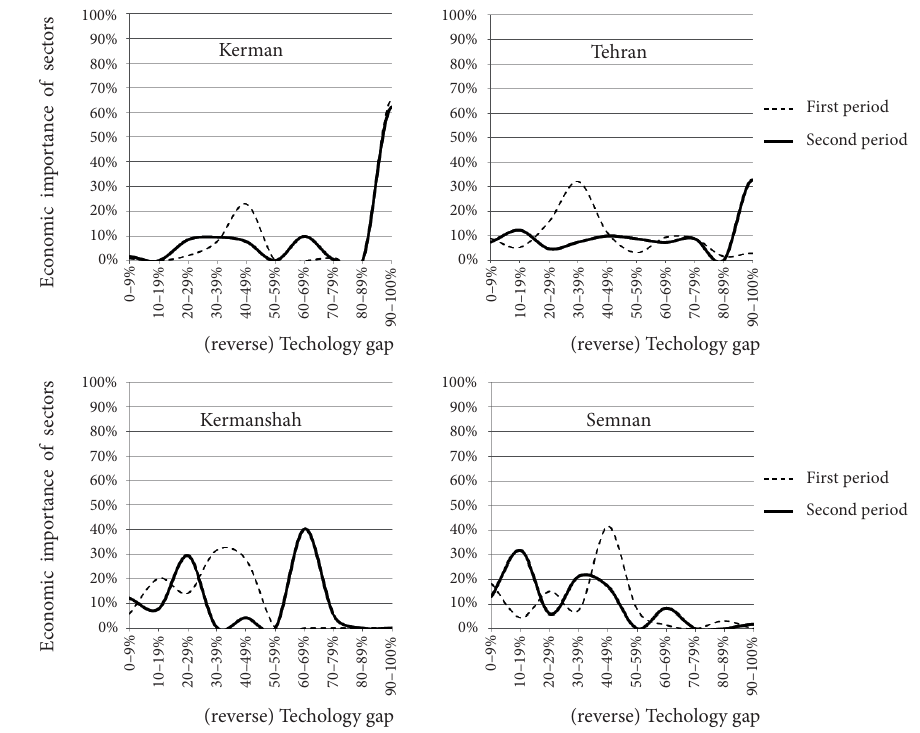
Fig. 3. Experimental catch-up patterns of four developing regions in